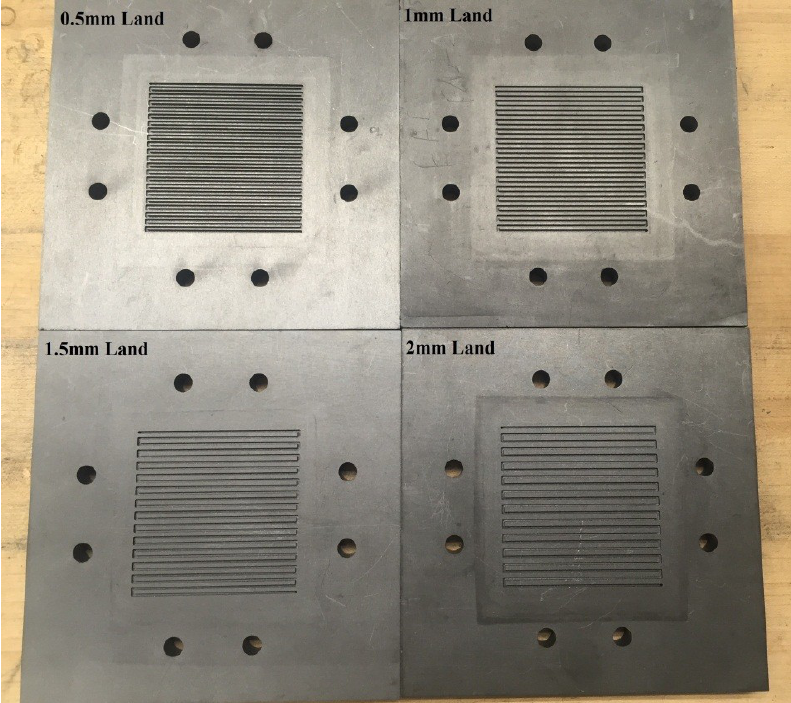
Figure 2. Single serpentine flow fields with four different land widths (0.5 mm, 1 mm, 1.5 mm, 2 mm).